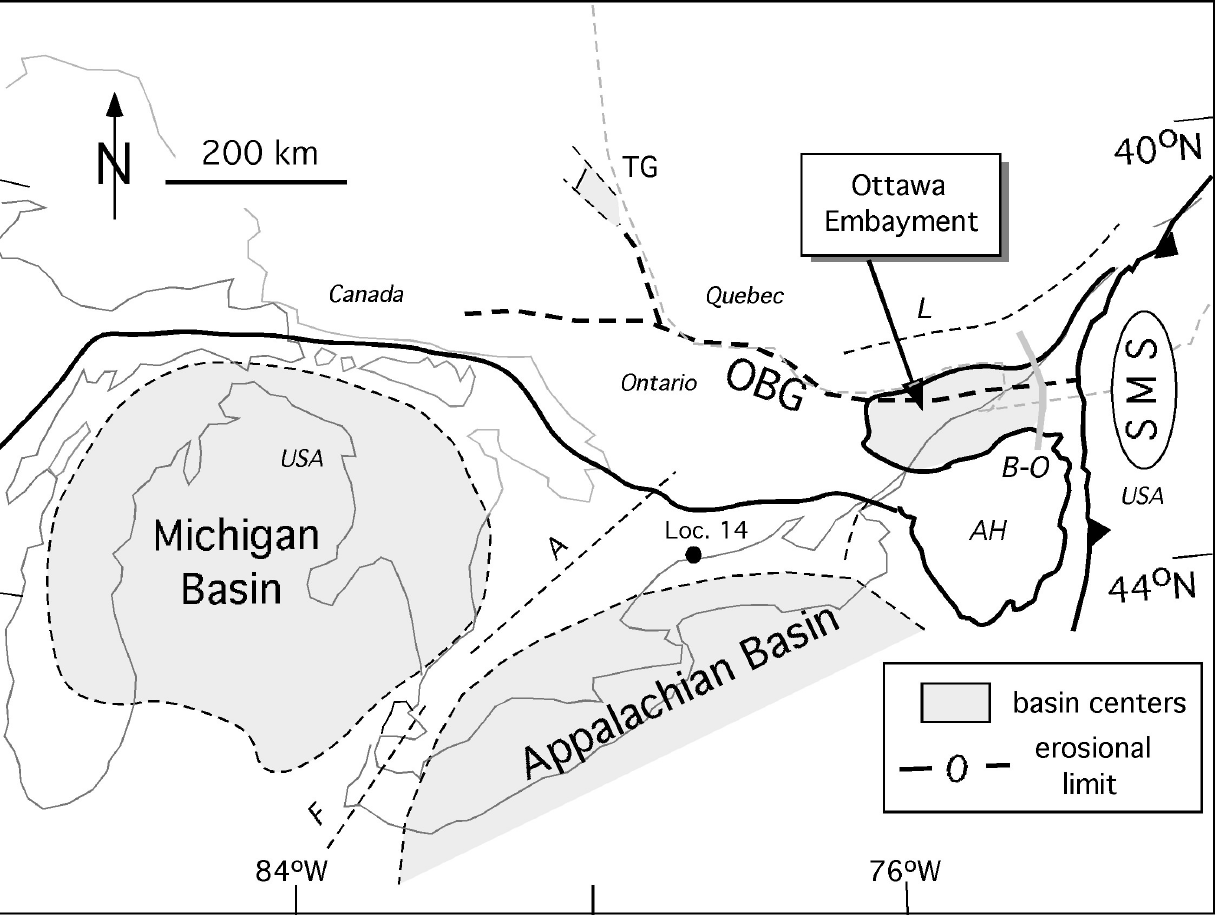
Figure 1. Regional distribution of sedimentary basins, Timiskaming graben (TG), local arches (A, Algonquin; F, Findlay; and, L, Laurentian), and trace of the Ottawa Bonnechere graben (OBG) west of the Sutton Mountains salient (SMS) of the Appalachian orogen [9]. Erosional limits of basins are shown by the heavy black line. Other abbreviations: B-O, Beauharnois-Oka arch; AH, Adirondack Highlands. The position of Locality 14 (see Table 1) is shown for